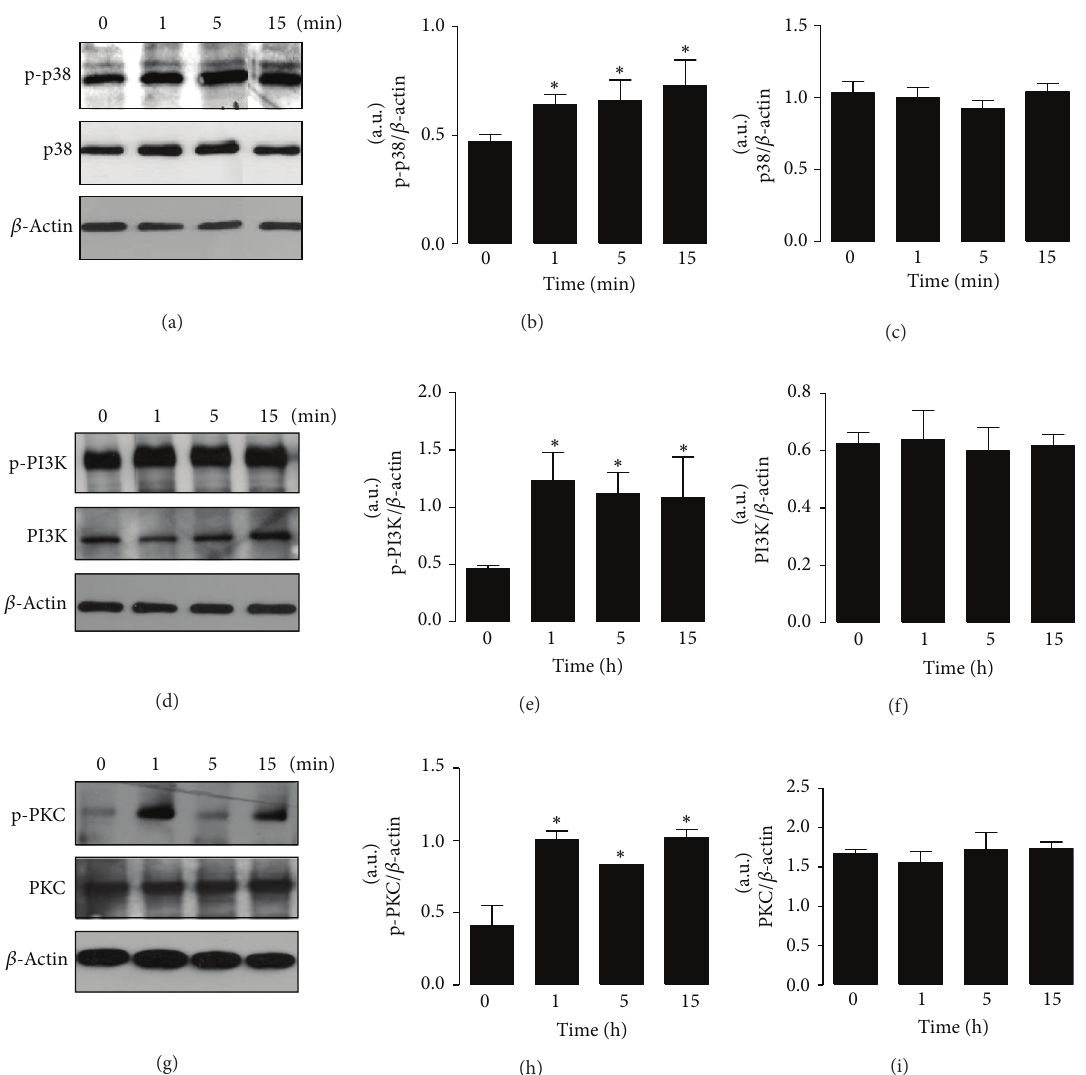
Figure 3: p38MAPK, PI3K, and PKC phosphorylation induced by MT-III in isolated peritoneal macrophages. Resident peritoneal macrophages ( 1 × 10 6 cells) were incubated during 1, 5, and 15min with MT-III (0.4 𝜇 M). (a, d, and g) Western blotting of p-p38MAPK, p38MAPK, p-PI3K, PI3K, p-PKC, PKC, and 𝛽 -actin (loading control). (b, c, e, f, h, and i) Densitometric analysis of immunoreactive band intensities. Results are expressed as mean ± SEM from 3 experiments. ∗ 𝑃 < 0.05 as compared to time